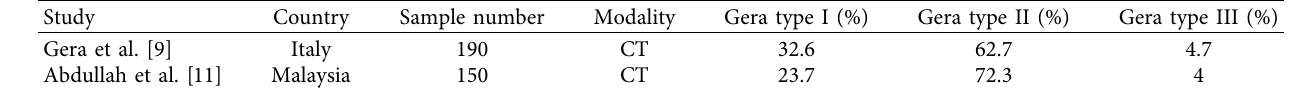
Table 8: The incidence of gera types in different